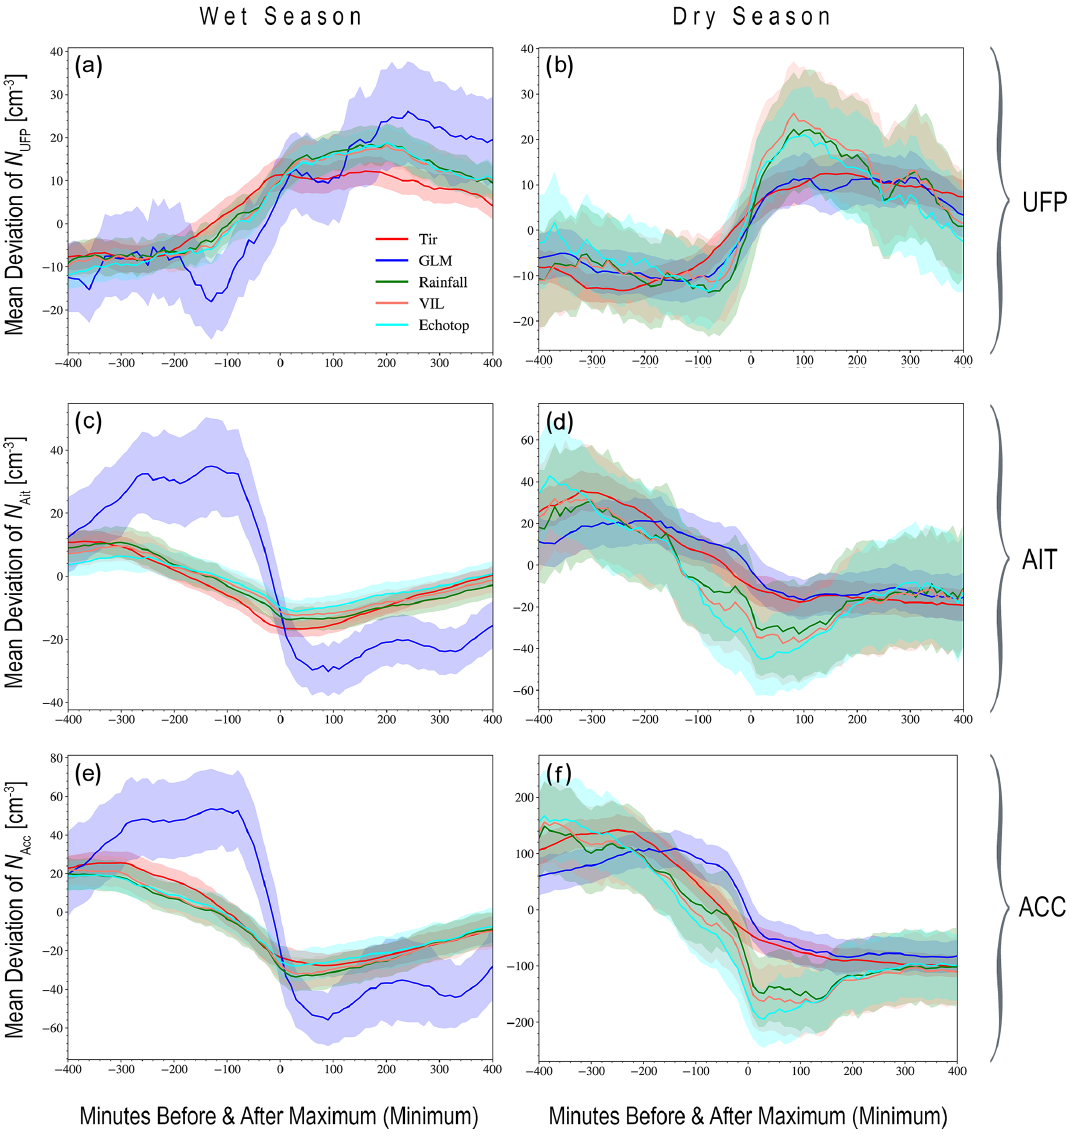
Figure 8. Composite reflectivity, vertically integrated liquid water (VIL), 20dBZ echo top, brightness temperature and lightning density for the percentile value of 65% for (a) N UFP during the wet season, (b) N UFP during the dry season, (c) N AIT for the wet season, (d) N AIT for the dry season, (e) N ACC for the wet season and (f) N ACC for the dry season (60m sampling height). The shaded area corresponds to the 95% confidence